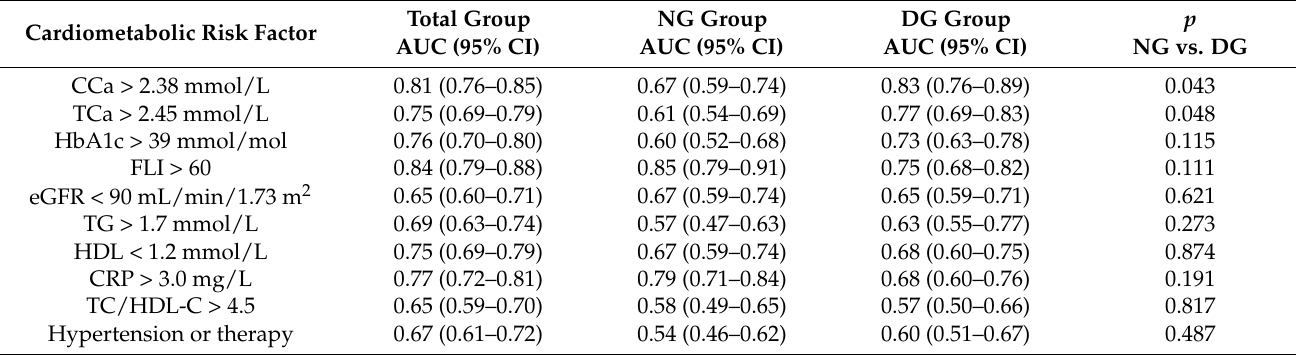
Table 4. AUC values for associations between BCAAs and cardiometabolic risk factors according to glycemic status. Cardiometabolic Risk